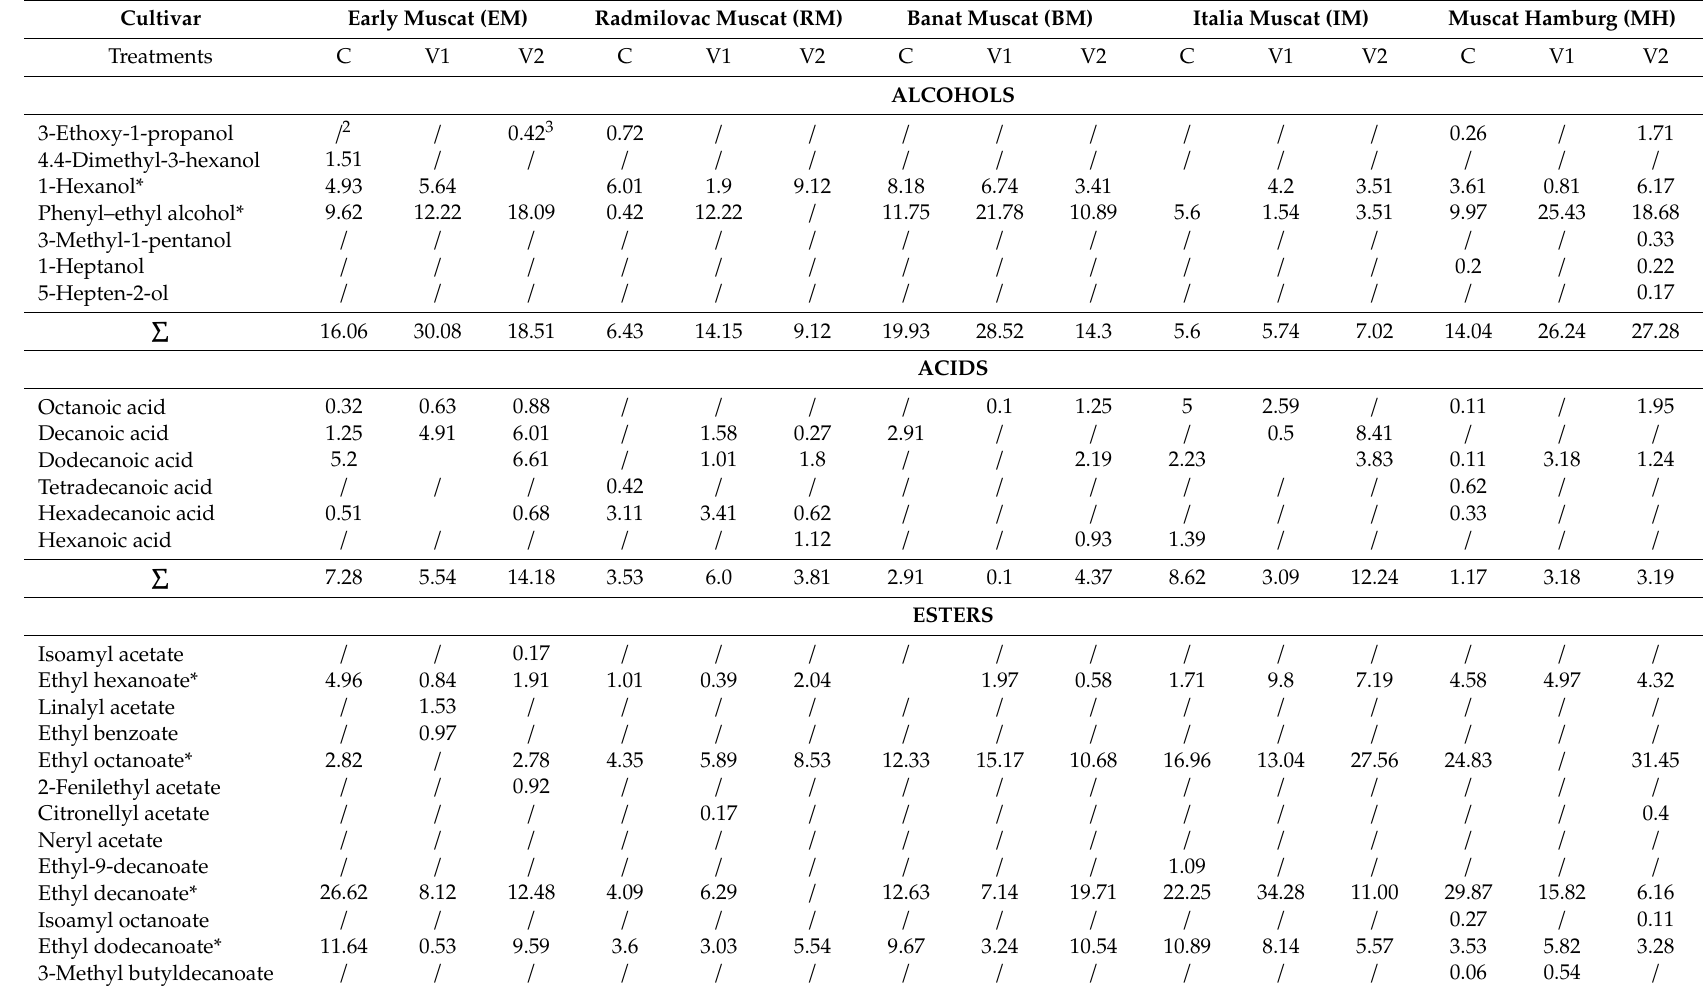
Table 1. Volatile aromatic compounds identified in Muscat table grape